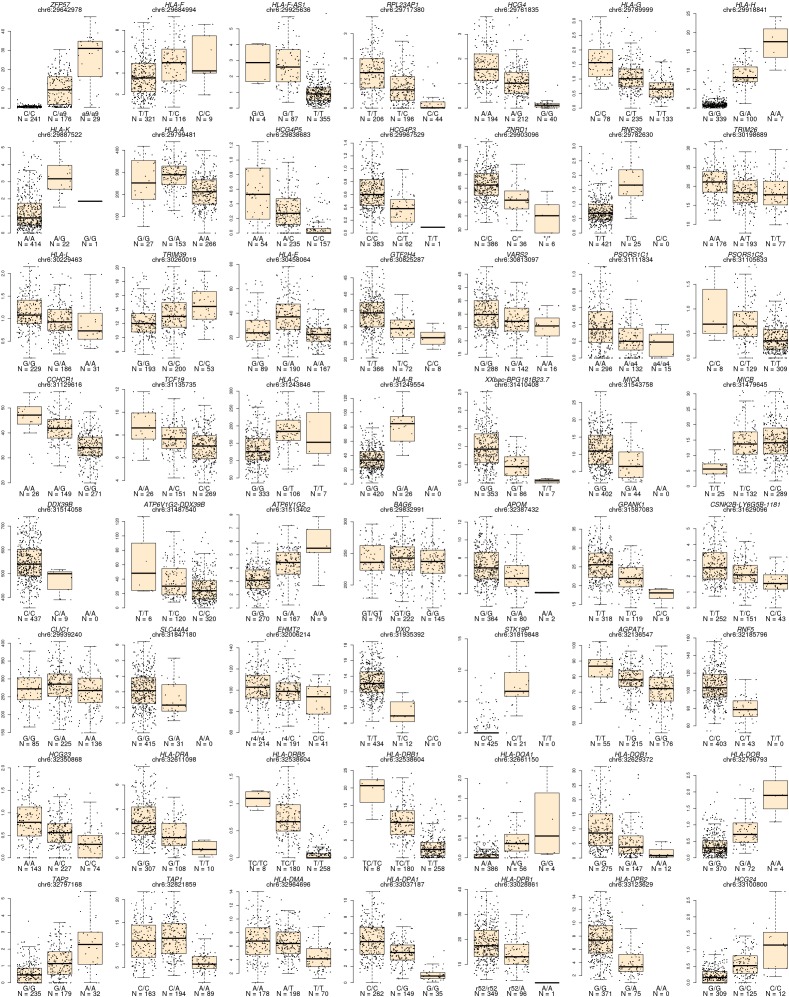
Lead eQTL associations for each eGene.Boxplots showing the expression levels of each of the 56 eGenes divided by the genotype of the lead eQTL. Above each plot the gene name and position of the lead eQTL are shown. Below each box the genotype and the number of samples associated with each genotype are indicated.